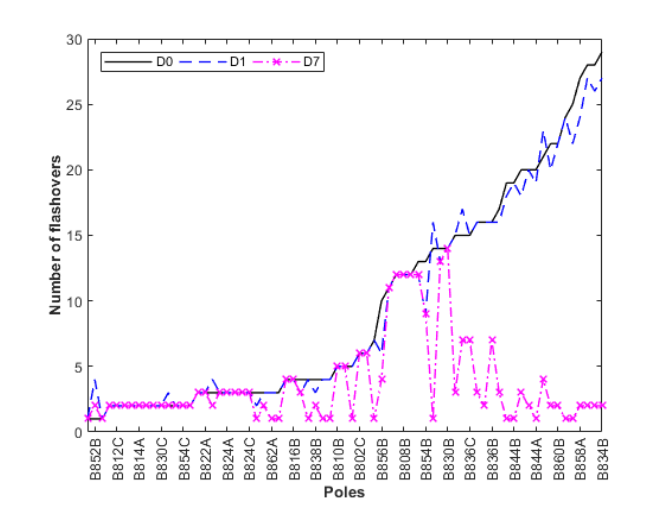
Figure 15. Comparing flashover occurrence reduction for the cases D0, D1, and D7, respectively.